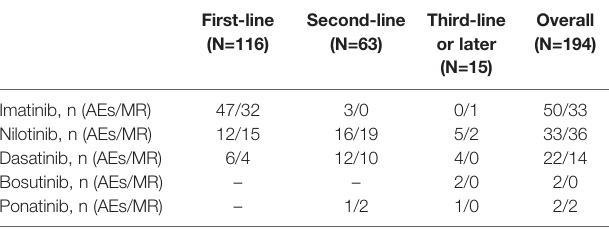
TABLE 2 | Reasons for dose reduction according to each